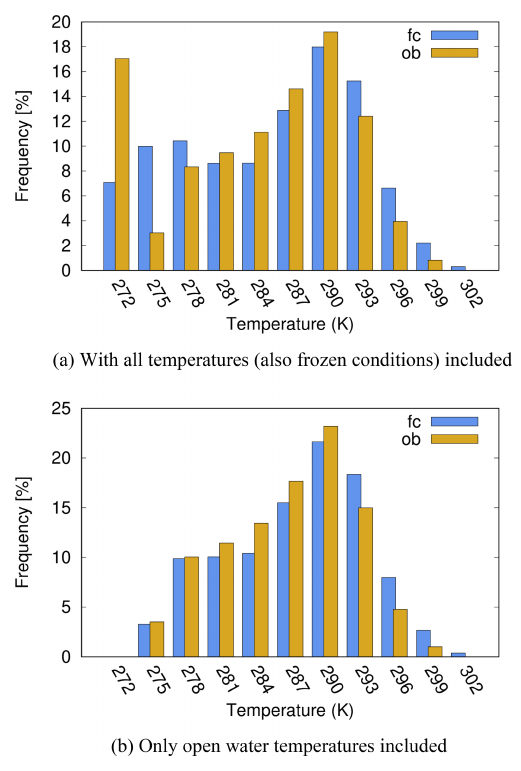
Figure 4. As for Fig. 3 but for observed (ob) and analysed (an) LSWTs. Table 2. Statistical scores for LSWT at all stations and at two se- lected